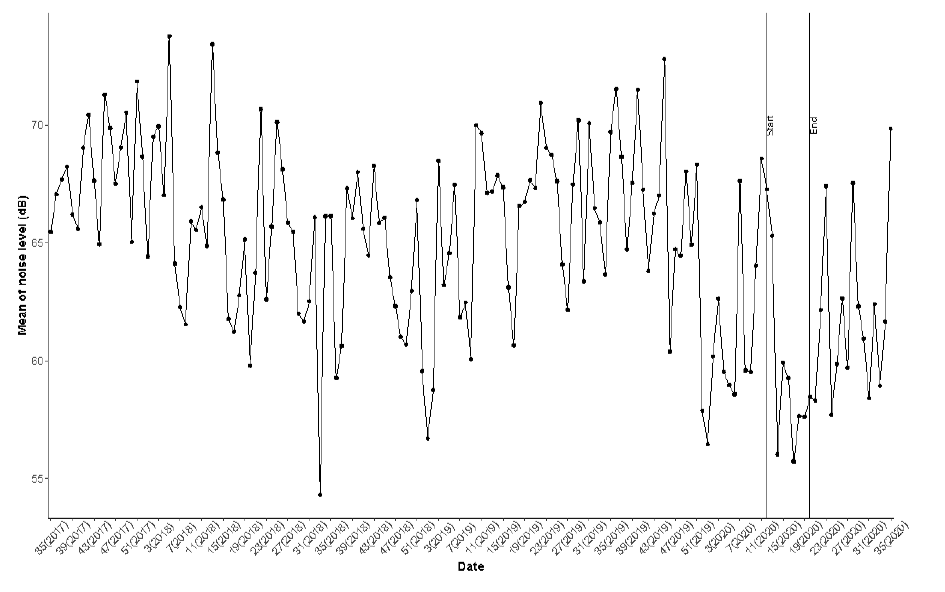
Figure 17. Distribution of mean ‘noise_level’ in France by week accompanied with 2 verticals lines that represent the start and end of the first